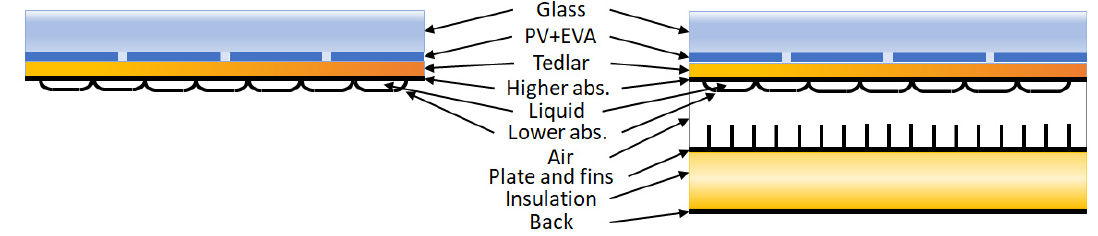
Figure 1. Cross-sections of the reference WISC PV/T ( left ) and bi-fluid PV/T collectors ( right ). The fins have a thickness of 1.0 mm and a height of 25.4 mm, and they are posed with a wheelbase of 25.0 mm, while the air channel has a thickness of 50.0